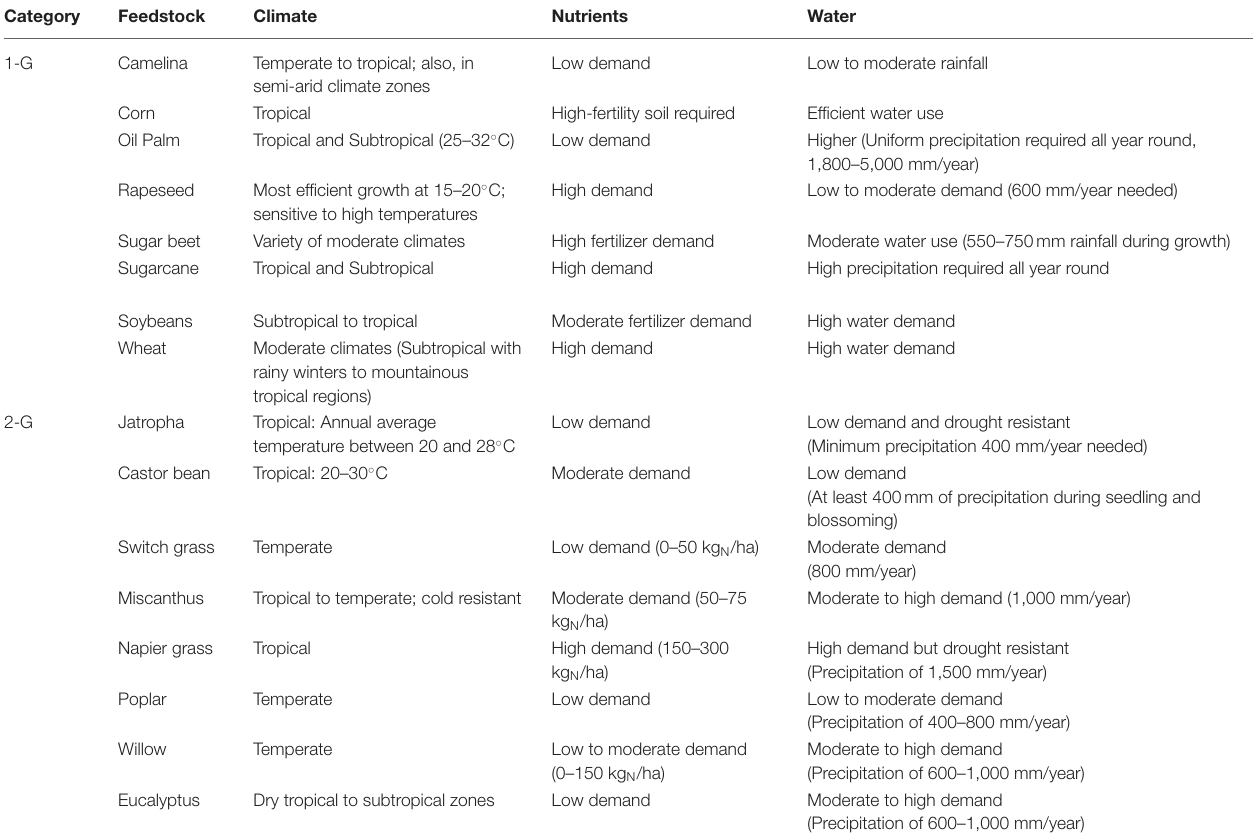
TABLE 4 | Comparison of the cultivation requirements of various 1-G and 2-G feedstocks (Escobar et al., 2009; Hickman et al., 2010; Fazio and Barbanti, 2014; Searle and Malins, 2014; Curneen and Gill, 2016; Surian Ganba et al., 2016; Liu W. et al., 2017; Campbell, 2018; Fabio and Smart, 2018; Fischer et al., 2018; Rödl, 2018).